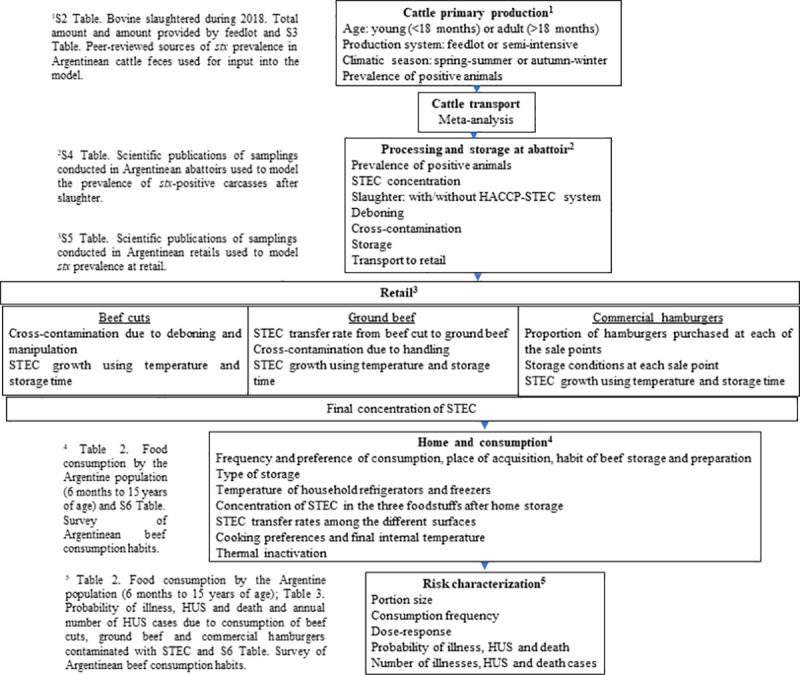
Beef supply chain conceptual model and relevant input variables.1
S2 and S3 Tables, 2
S4 Table, 3
S5 Table, 4
Table 2 and S6 Table, 5Tables 2 and 3 and S6 Table.